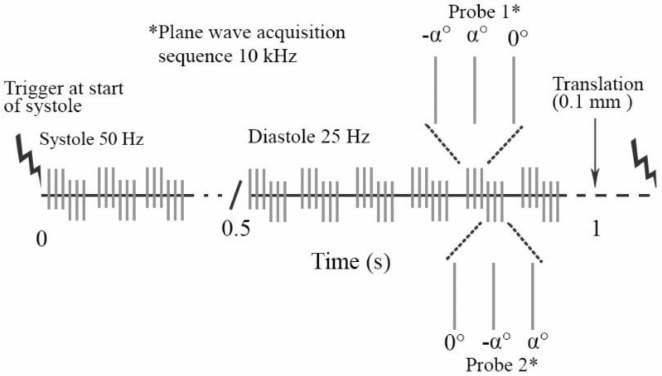
Figure 3. Schematic of the temporal acquisition protocol applied using an interleaved dual probe